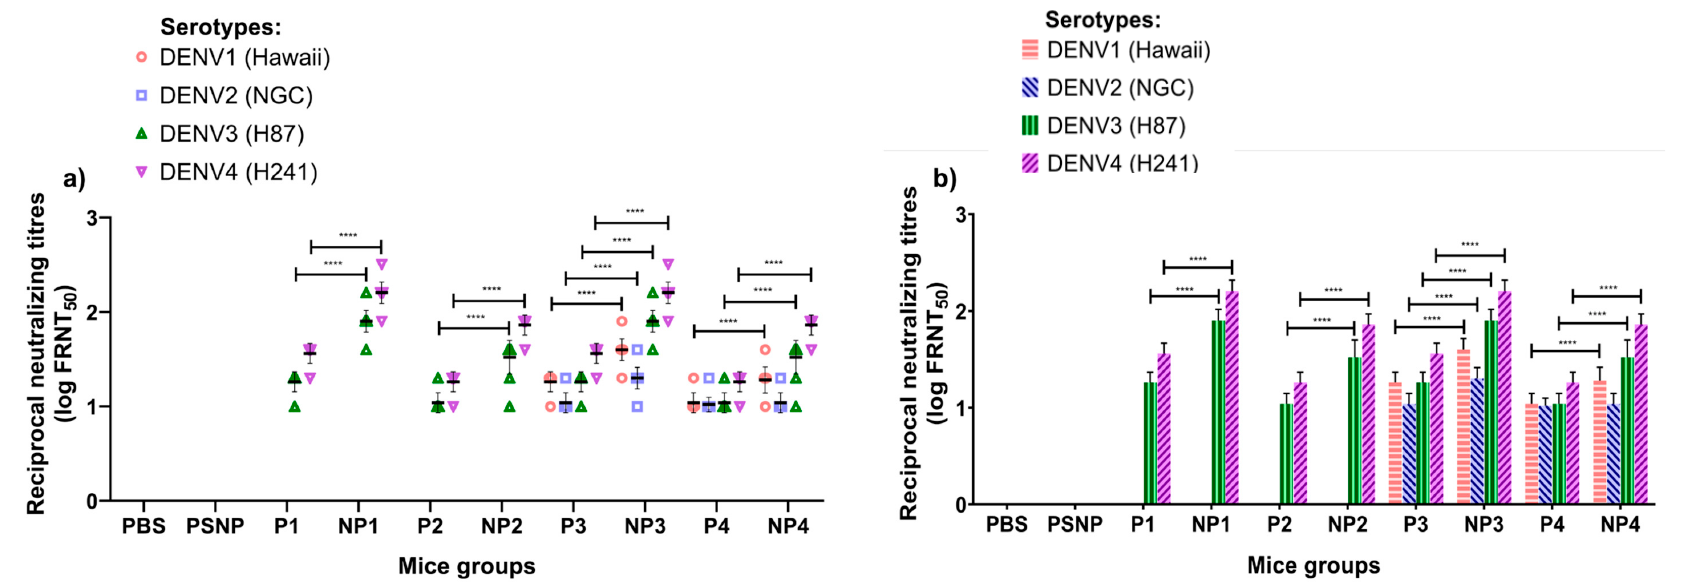
Figure 2. Neutralizing activity of anti-peptide antibodies against four dengue virus (DENV) serotypes. ( a ) Each dot represents the reciprocal antibody titer (log FRNT 50 ) from an individual mouse in each group. ( b ) The average of reciprocal antibody titers (log FRNT 50 ) in each mouse group. Data from triplicate assays were plotted using Graph Pad Prism Version 8.02 (Graph Pad Software Inc., San Diego, CA, USA) and expressed as the mean and SDs (one-way ANOVA analysis with Tukey’s multiple comparison test: **** p < 0.0001).